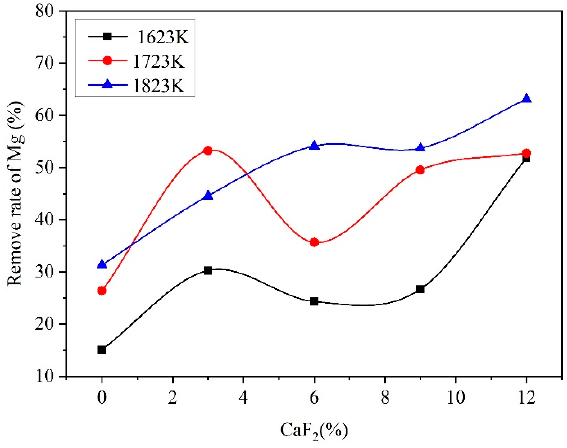
Figure 16. The effect of additives and temperature of Mg removal rate (%).